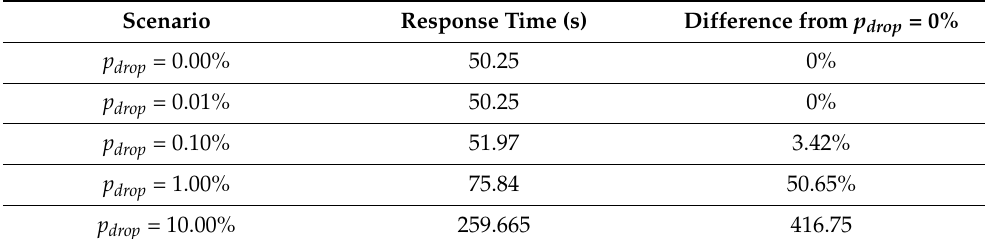
Table 8. Download Response Time in Virtualized Network Environment.